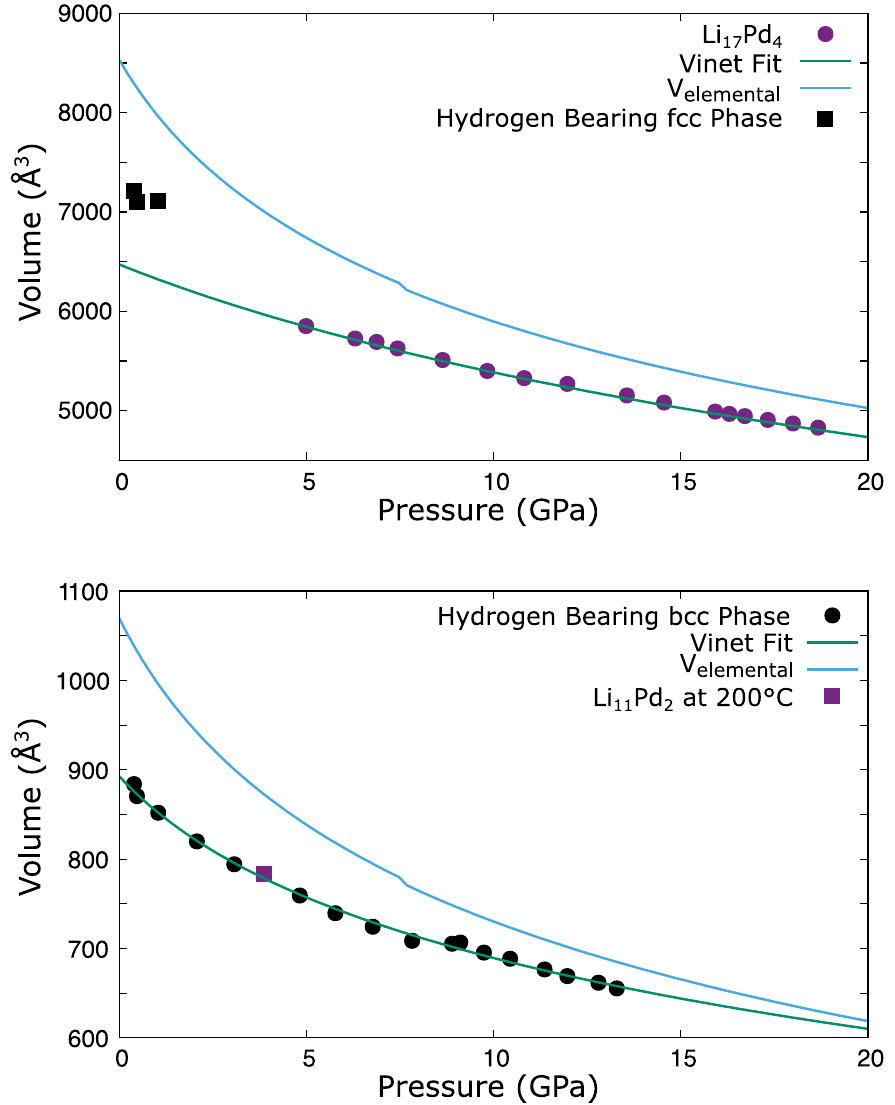
¯ 43 m Figure 10. Volume vs pressure plots. Top: the Li 17 Pd 4 F phase (fuchsia circles) and low-pressure fcc hydrogen bearing phase (black squares). The green line is a Vinet fit to the circle points, note that hydrogen bearing fcc phase lies off this curve. The blue line is the volume of an equivalent number of lithium (340) and palladium (80) atoms in the elemental form 20,30,32 . Bottom: the bcc hydrogen bearing phase (black circles) and Li 11 Pd 2 I ¯ 43 m phase at 200 ◦ C (fuchsia square). The green Vinet fit is to the circle points. The blue line is the volume of 44 lithium and 8 palladium atoms in elemental form, corresponding to Li 11 Pd 2 . The